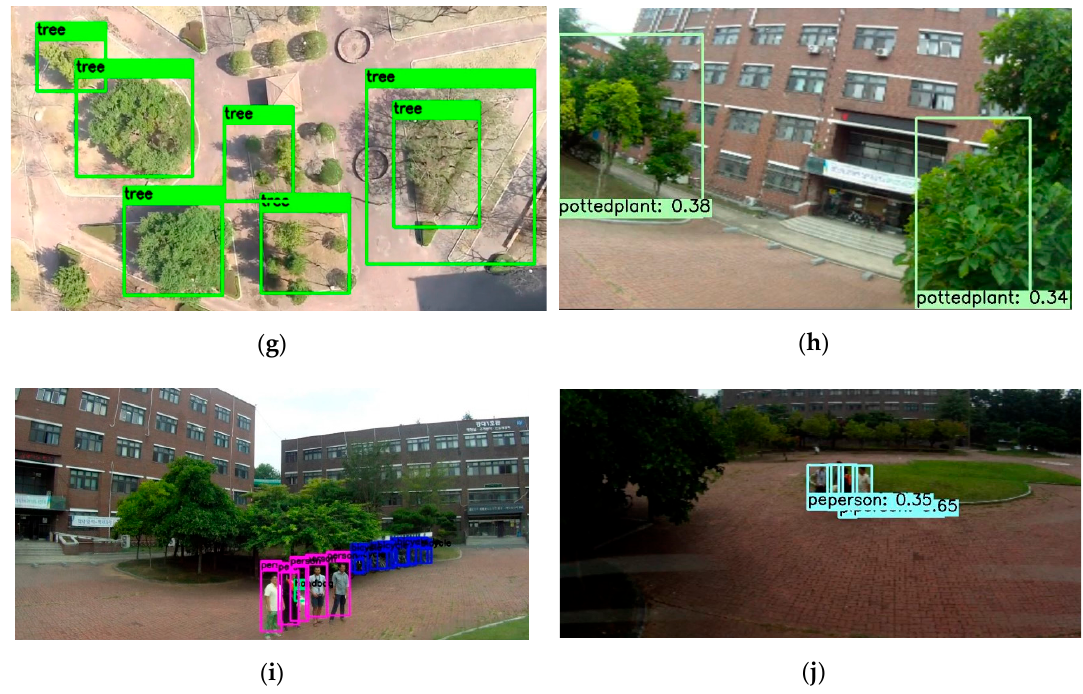
Figure 13. Target detection results of ( a ) real-time segmentation using DeepLabv-3 using Xavier, ( b ) faster R-CNN using TX2, ( c ) YOLOv2 using TX2, ( d ) faster R-CNN using Xavier, ( e ) YOLOv3 using